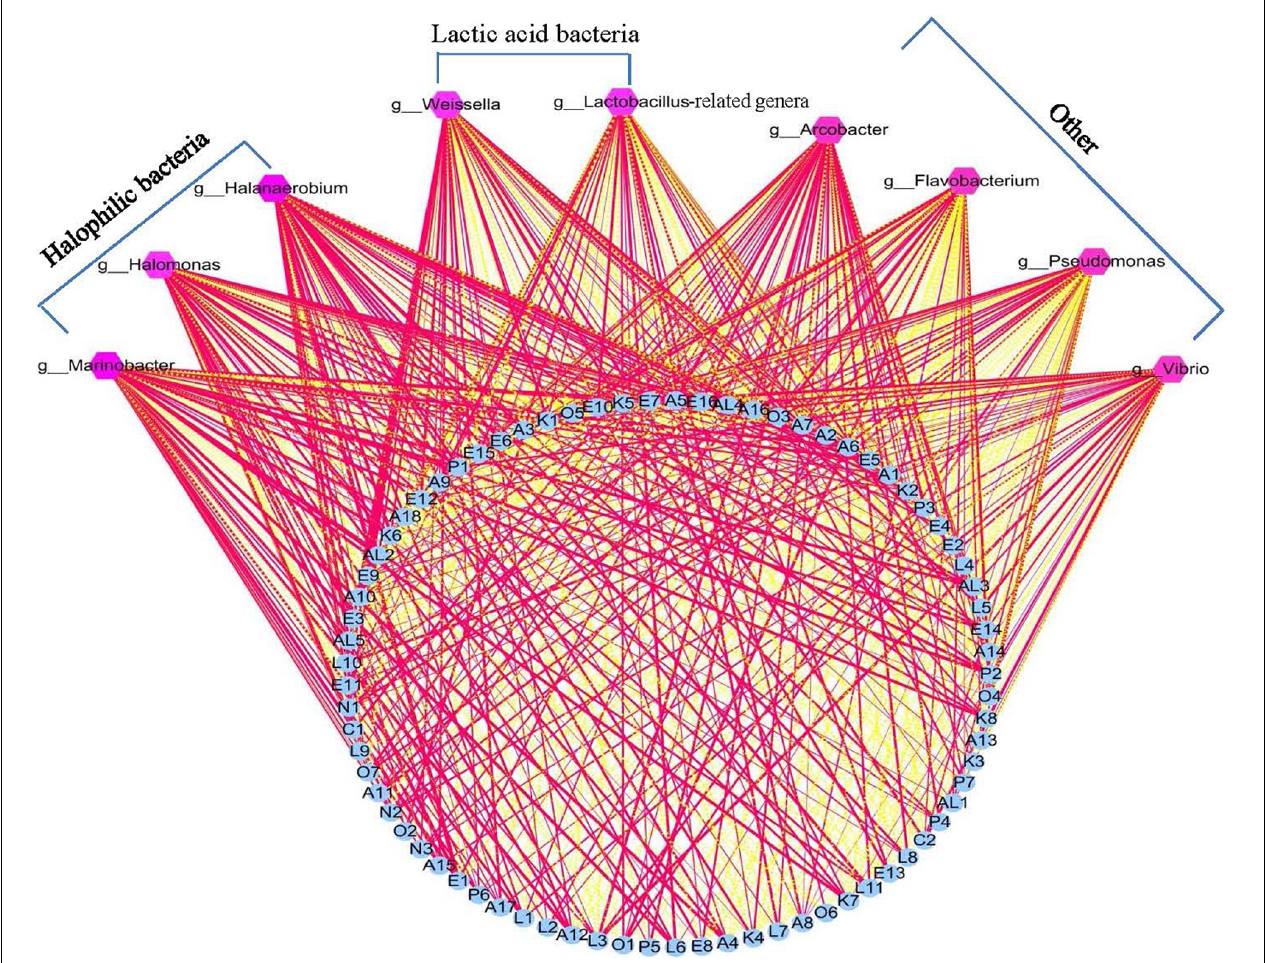
FIGURE 4 | Visualization of the correlation network according to significant correlations between flavor compounds and the relative abundance of the bacteria. Each blue roundness represents a flavor compound, each pink polygon represents a genus. The red solid line and yellow dotted line represents positive and negative correlation, respectively. In addition, line width indicates the strength of correlation. For interpretation of the code in this figure, the reader is referred to the Table 2 and Supplementary Table 2